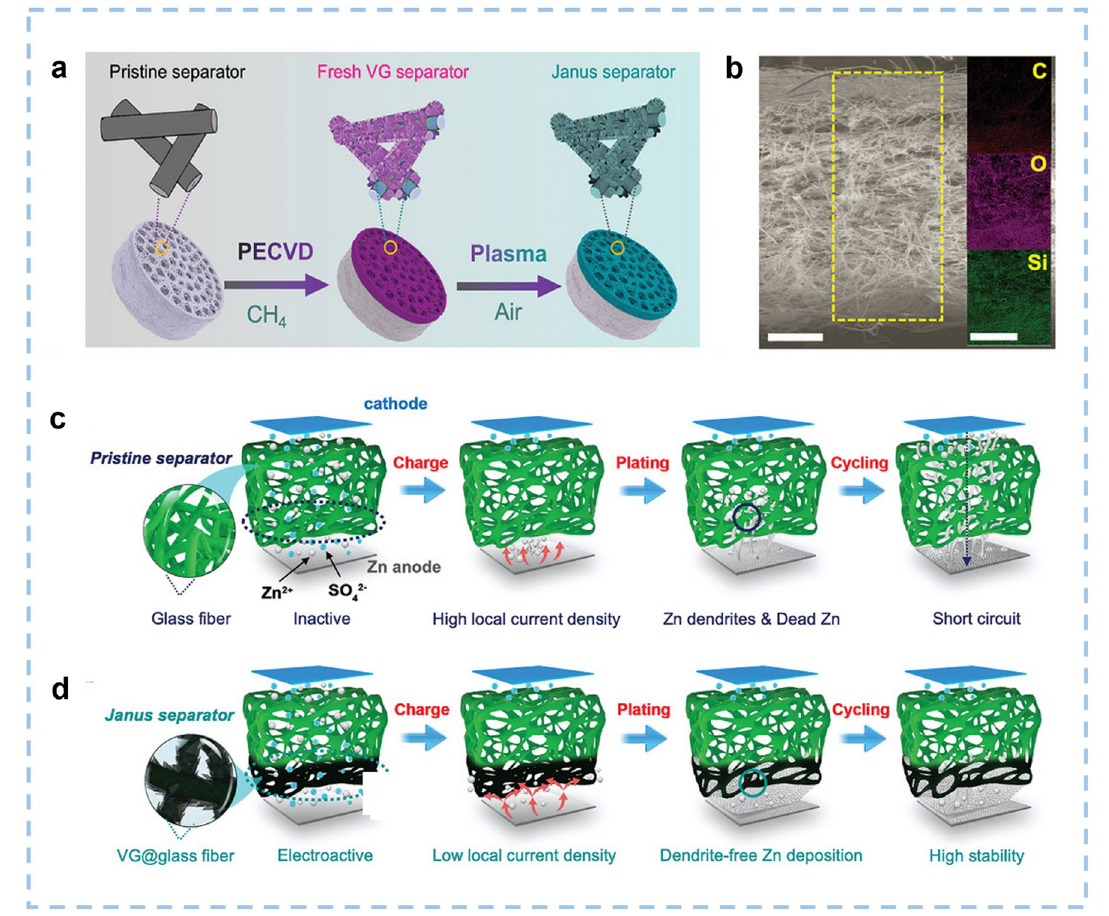
Fig. 14 Schematics of the preparation process, morphology, and structure of the Janus separator, and the design of the Janus separator target- ing stabilized Zn anode. a Schematic representation of synthetic process of Janus separator. b Cross-section SEM image of Janus separator and corresponding EDS maps. c A pristine glass fiber separator, and d a Janus separator harnessing one-side directly grown VG carpet to help lower local current density and homogenizing ion distribution. Reproduced with permission [197]. Copyright 2020,